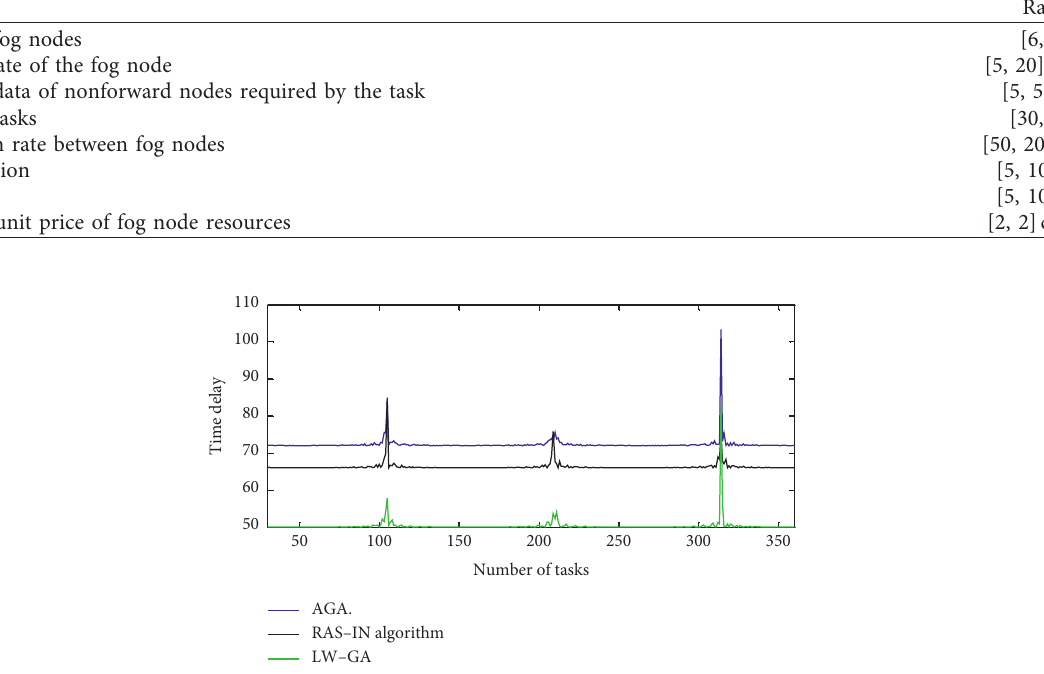
Figure 5: Delay comparison of the three algorithms.